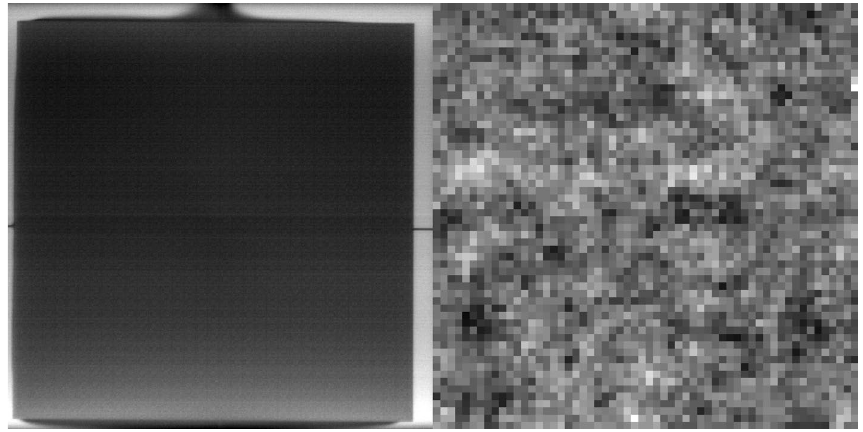
Figure 6. Left: Single image of the repeated MURA pattern with an approximate effective 2.75 µm pixel size. Right: Magnified view showing a 58 × 58 pixel region representing a single MURA sequence.